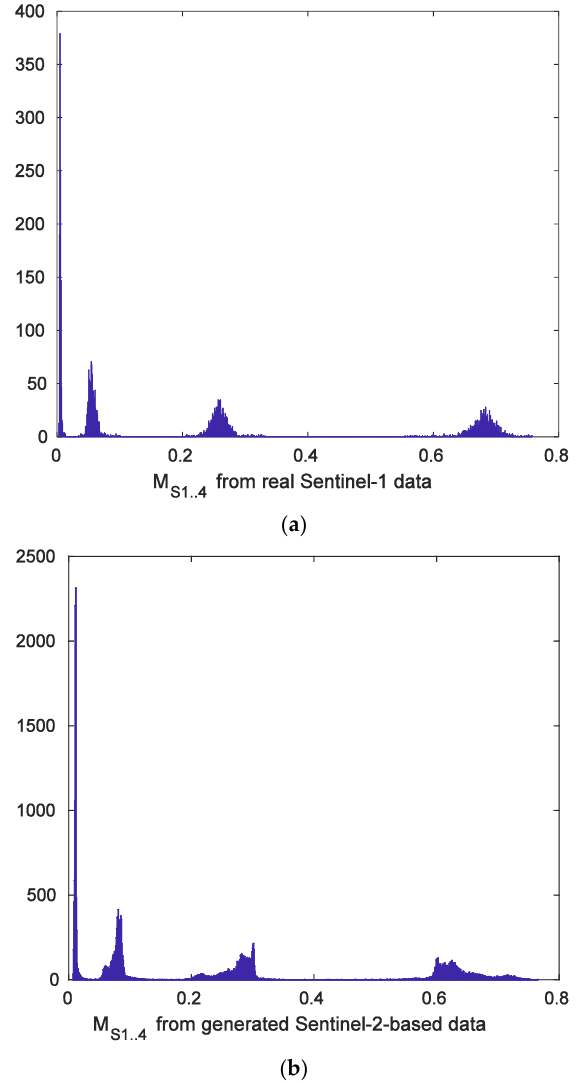
Figure 5. Histograms of M S 1 , M S 2 , M S 3 , and M S 4 for real-life Sentinel-1 images ( a ) and simulated data using Sentinel-2 images ( b ).